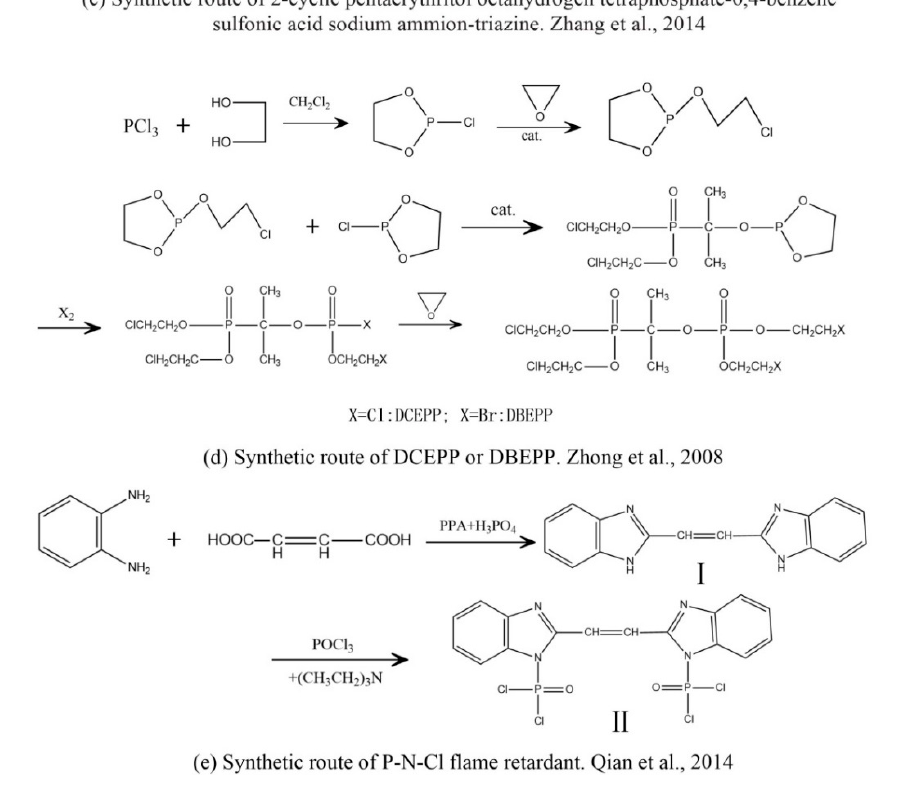
Figure 1. Synthetic routes of five Organophosphate flame retardants (OPFRs).